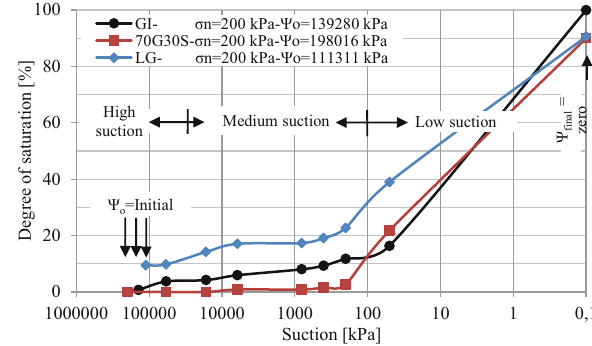
Figure 7: Variation of the degree of saturation with suction of the ( CN - SD ) wetting test.